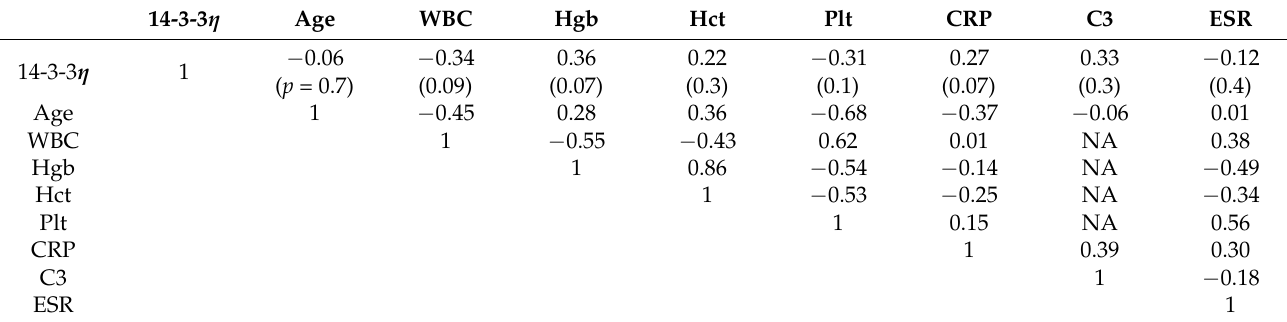
Table 6. Spearman’s Rank Correlation ( ρ ) for Positive 14-3-3 η